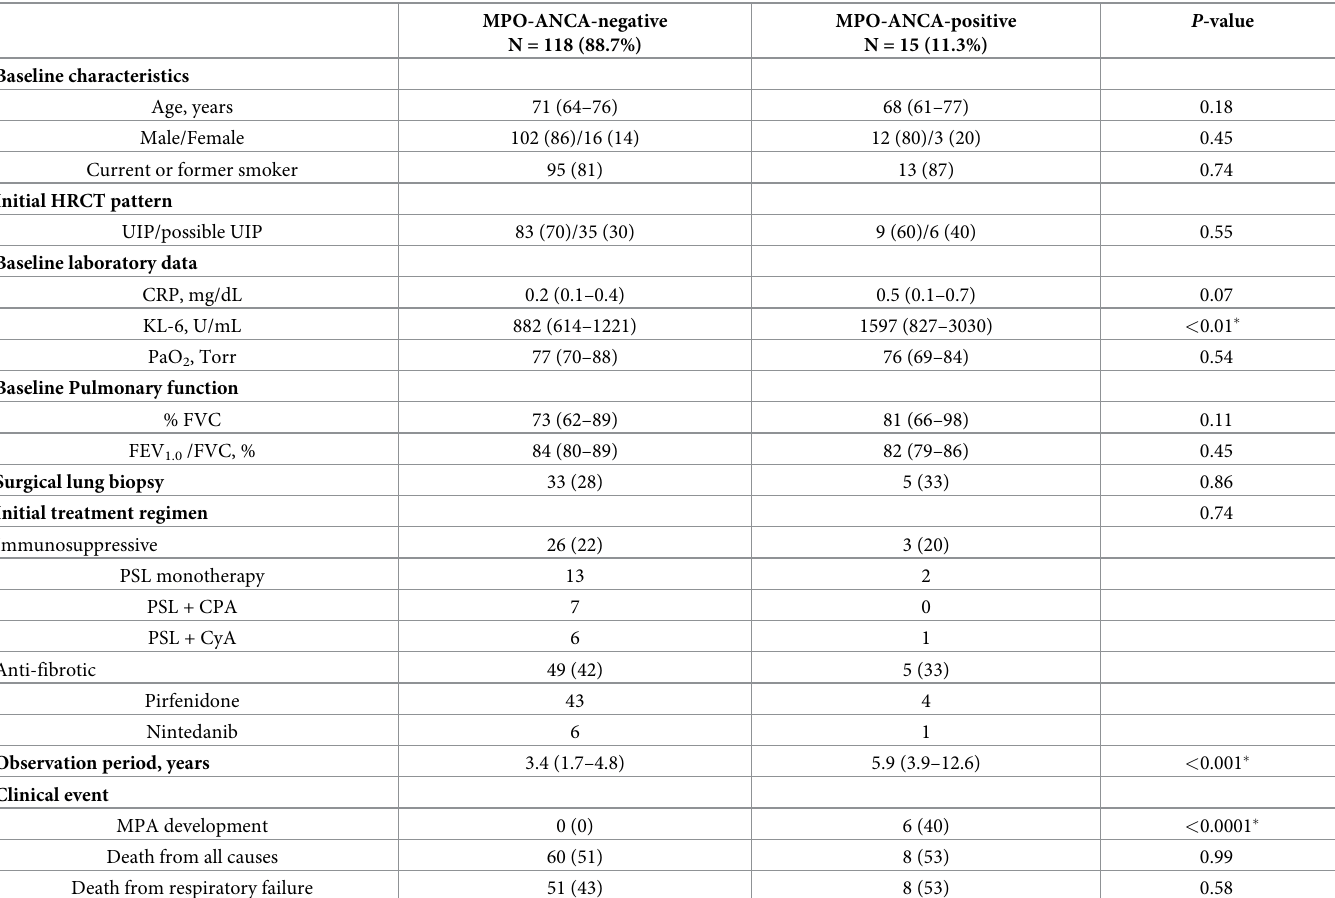
Table 1. Comparison of patients who were initially diagnosed as having IPF on the basis of MPO-ANCA